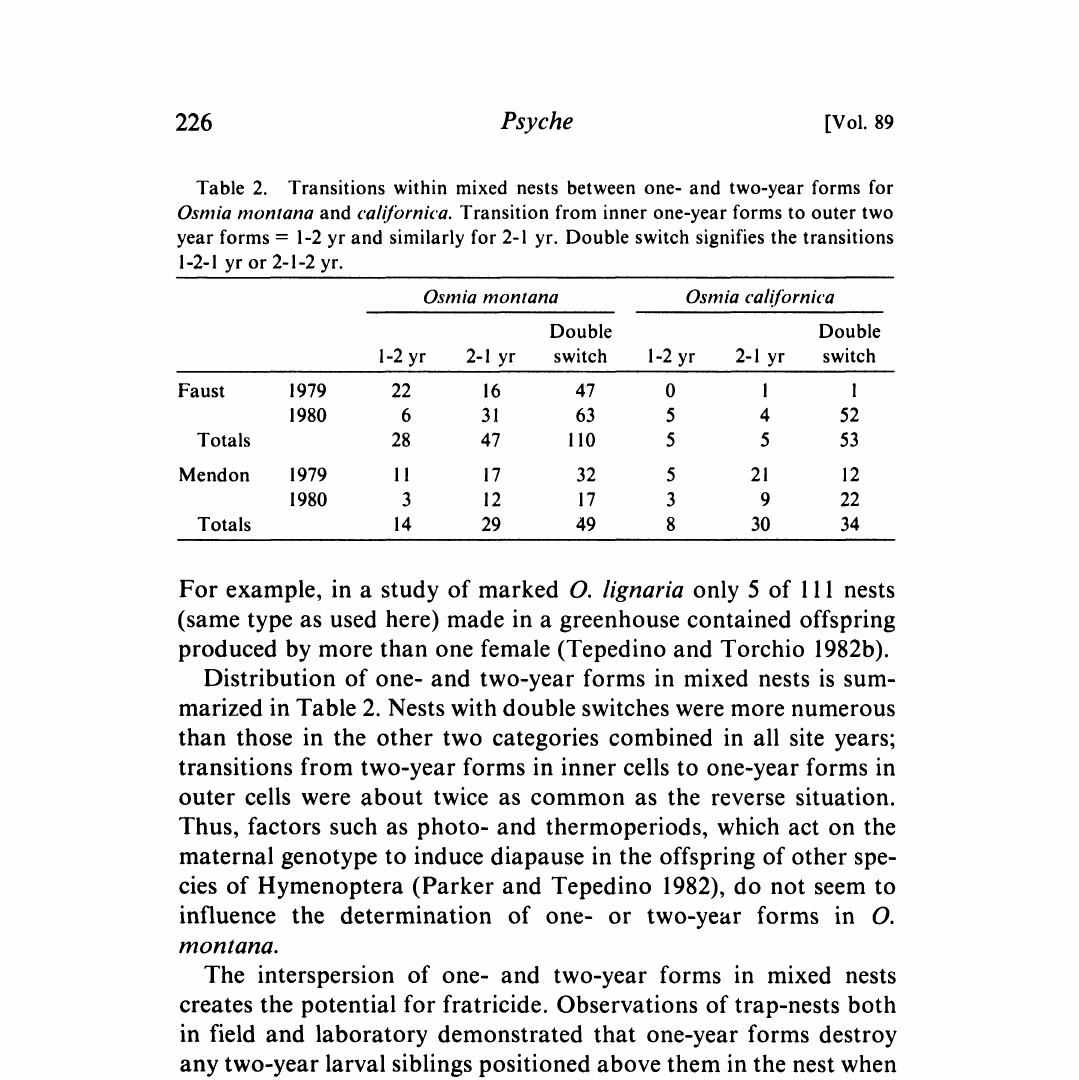
226 Psyche [Vol. 89 Table 2. Transitions within mixed nests between one- and two-year forms for Osmia montana and caliJbrnica. Transition from inner one-year forms to outer two year forms 1-2 yr and similarly for 2-1 yr. Double switch signifies the transitions 1-2-1 yr or 2-1-2